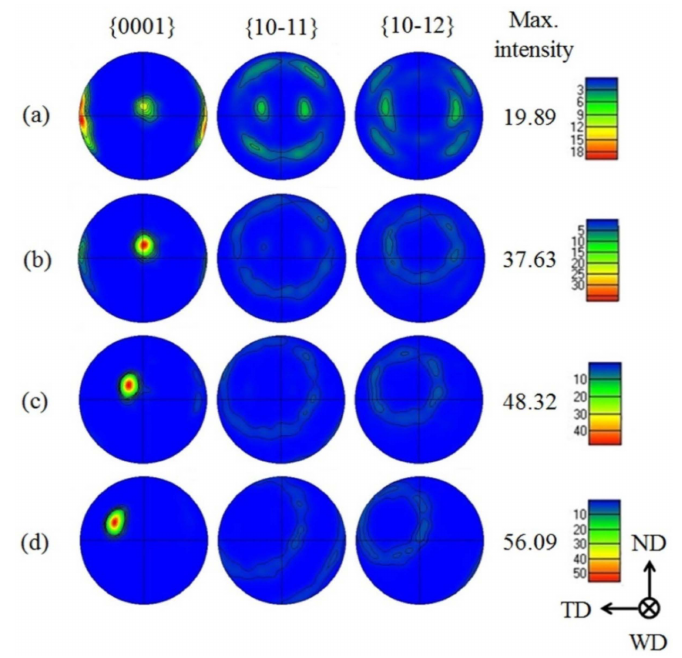
Figure 11. The pole figures in di ff erent positions in region 1 of FSW AZ31Mg alloy joint after base bending ( a ) → ( d ) from below to top.